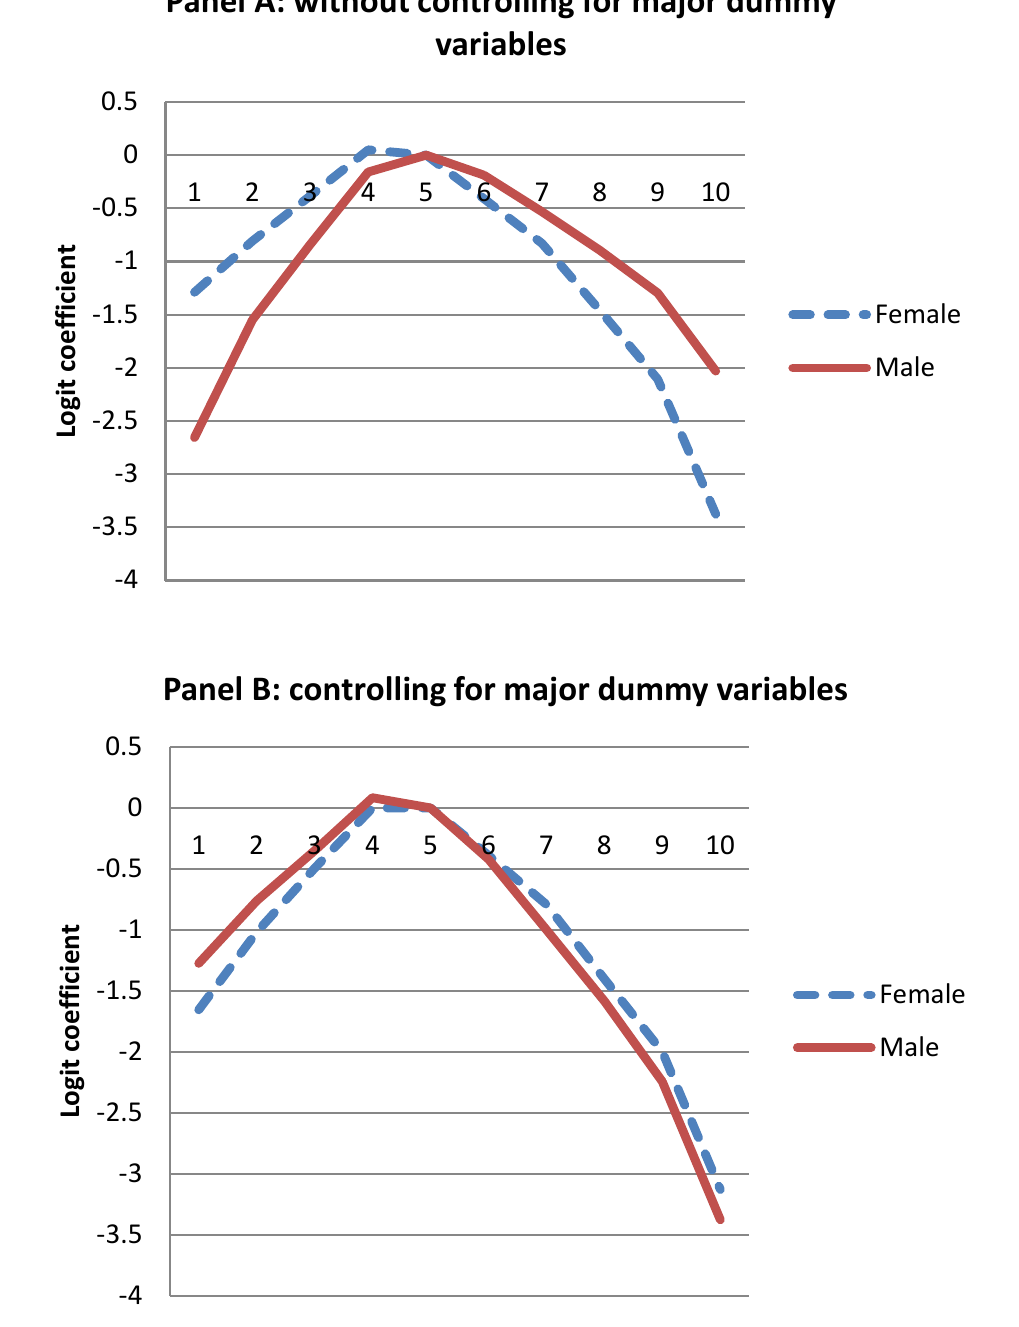
Figure 4: Unidimensional Preferences Model: Effects of Difficulty of Being Accepted on Choice, TECH. Based on the results of Table 3. (A) Without controlling for dummy variables. (B) Controlling for dummy variables.